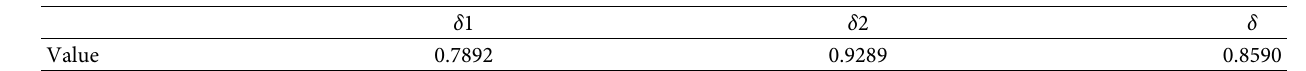
Table 6: .e consensus threshold.